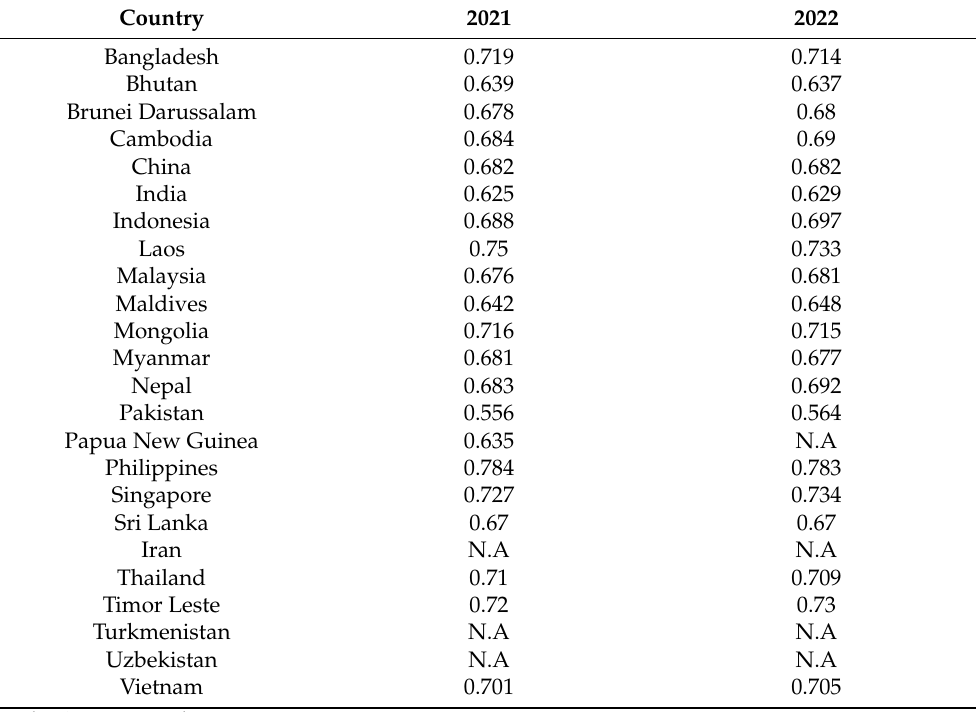
Table A2. Comparative Points of GGG 2021 and